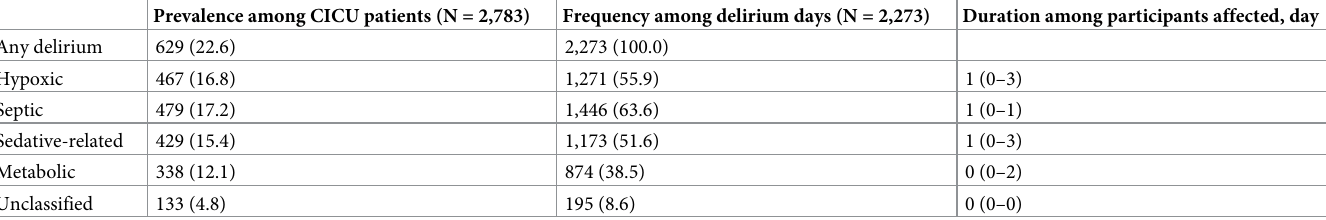
Presented values are medians with interquartile ranges in parentheses or numbers with percentages in parentheses. CICU, cardiac intensive care